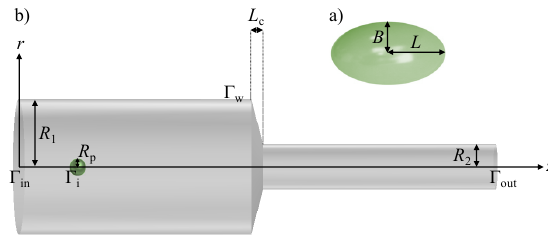
Figure 1. a) Schematic drawing of an elastic particle deformed into a prolate spheroid. b) Geometry of an initially spherical elastic bead suspended in a Newtonian liquid flowing through a device consisting of two coaxial cylindrical